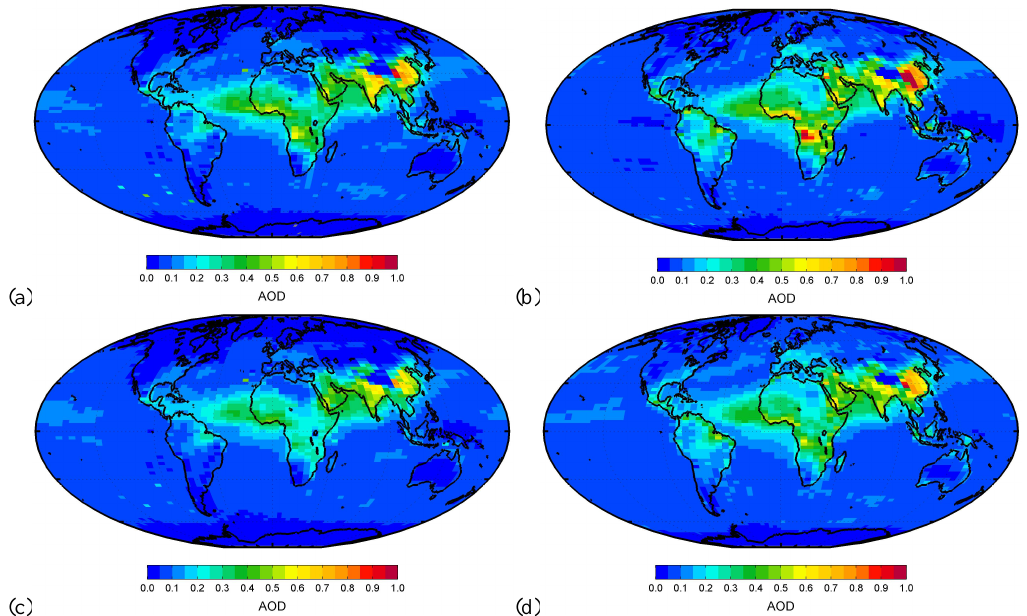
Fig. 3. Mean 532nm AOD, January 2007–December 2011: (a) cloud-free, daytime; (b) cloud-free, nighttime; (c) all-sky, daytime; (d) all-sky, nighttime.